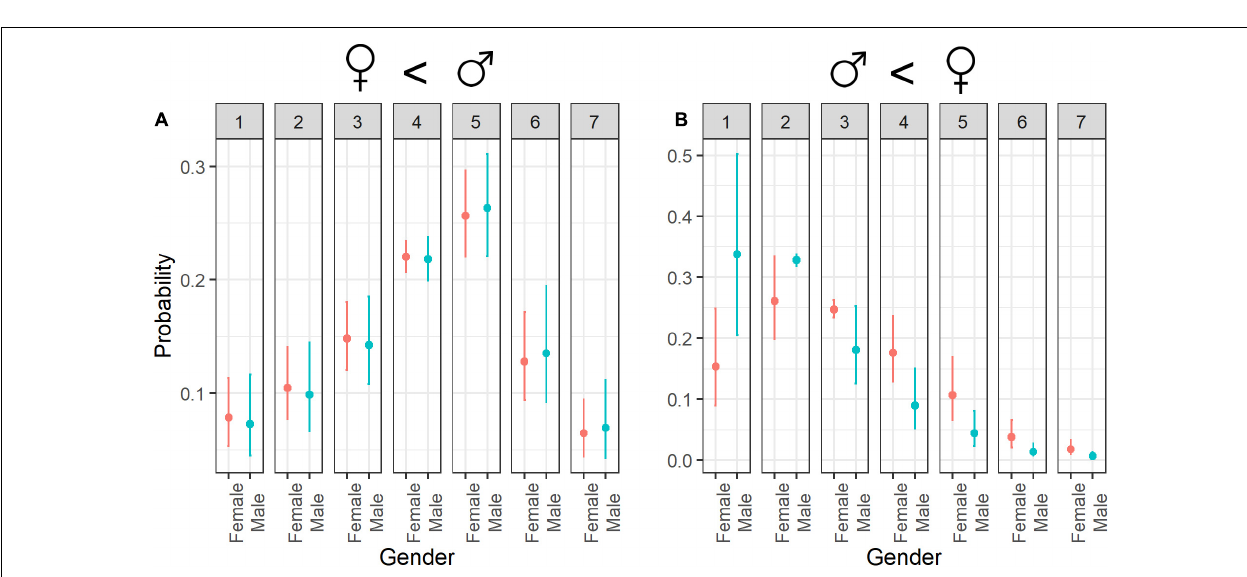
FIGURE 8 | Estimated probability of ratings for (A) cuteness and (B) fear according to Gender. Error bars indicate 95% confidence interval; numbers 1–7 refer to rating scores.